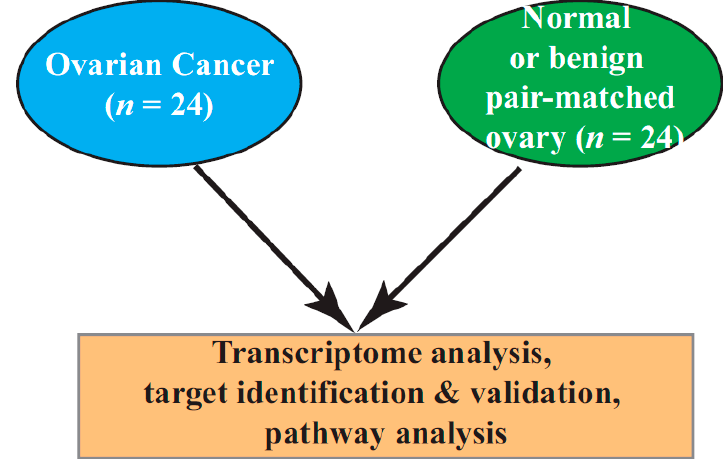
Figure 1. Experiment design. Ovarian cancer specimens (mostly histological grade 3) and adjacent normal tissue specimens ( n = 24) were used in gene expression microarray experiments and pathway analyses. Table 1. Patient characteristics.